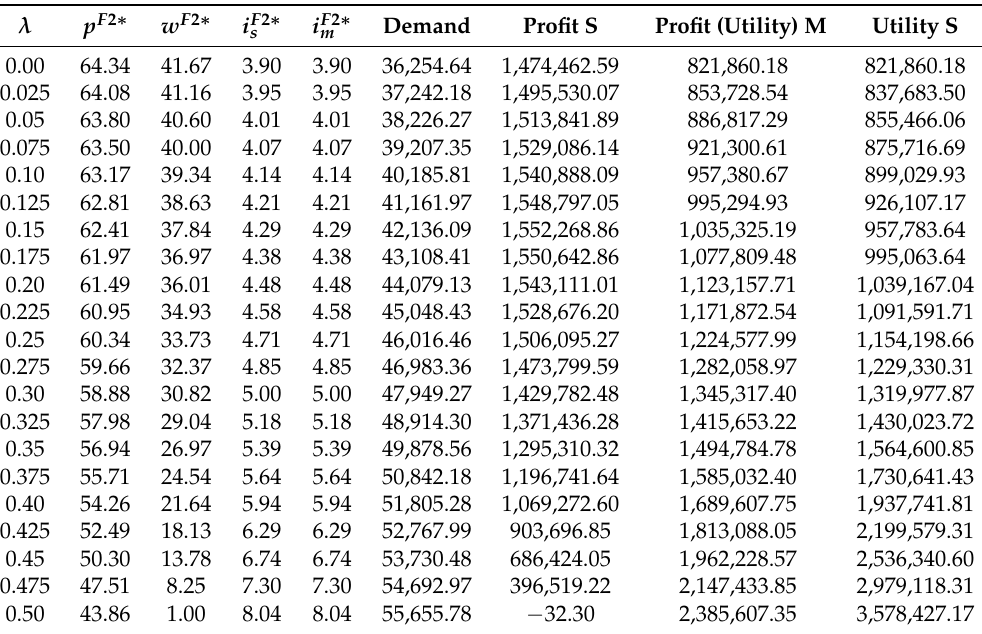
Figure 3. Impact of θ on the utilities when only the supplier concerns about fairness. Table 2. Impact of λ when the manufacturer concerns about